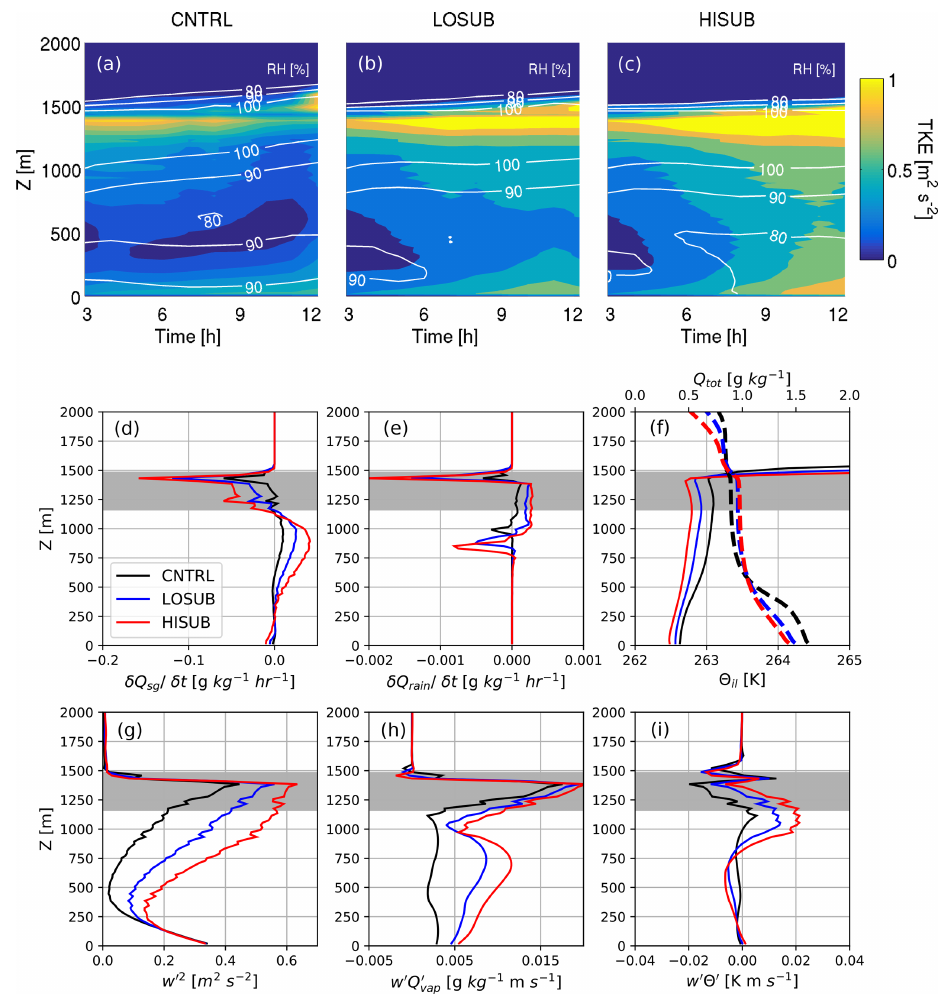
Figure 3. (a–c) Total turbulent kinetic energy (TKE, shading) and relative humidity (RH, white contours) time series for differing levels of subsidence. (d–i) Vertical profiles, at 9h, of (d) solid precipitation (snow + graupel) mass tendency ( δQ sg /δt ), (e) rain mass tendency ( δQ rain /δt ), (f) ice–liquid potential temperature ( (cid:50) il , solid) and total water mixing ratio ( Q tot , bold dashed), (g) vertical velocity variance ( w (cid:48) 2 ), (h) vertical flux of water vapour ( w (cid:48) Q (cid:48) vap ), and (i) buoyancy flux ( w (cid:48) (cid:50) (cid:48) ). (g–i) w (cid:48) 2 , w (cid:48) Q (cid:48) vap , and w (cid:48) (cid:50) (cid:48) are total quantities (sub- grid + advected). w (cid:48) 2 is used as an indicator for circulation strength, whilst the total (advected plus sub-grid) water vapour and buoyancy fluxes illustrate the mean dynamical motions in the BL. A combined measure of sub-grid and advected fluxes are shown as these are of similar orders of magnitude and both make a non-negligible contribution to the flux budget (not shown, Fig. S7). In particular, the sub-grid w (cid:48) Q (cid:48) vap fluxes are dominant in cloud and near the surface, due to the stability of these layers. Area in grey represents CNTRL cloudy